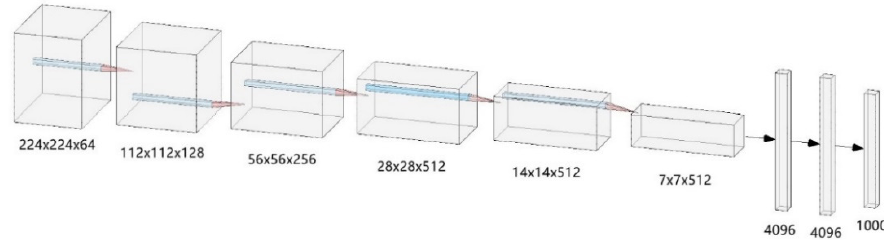
Figure 2. Architecture of the VGG-19 model. The boxes represent the size of each layer.